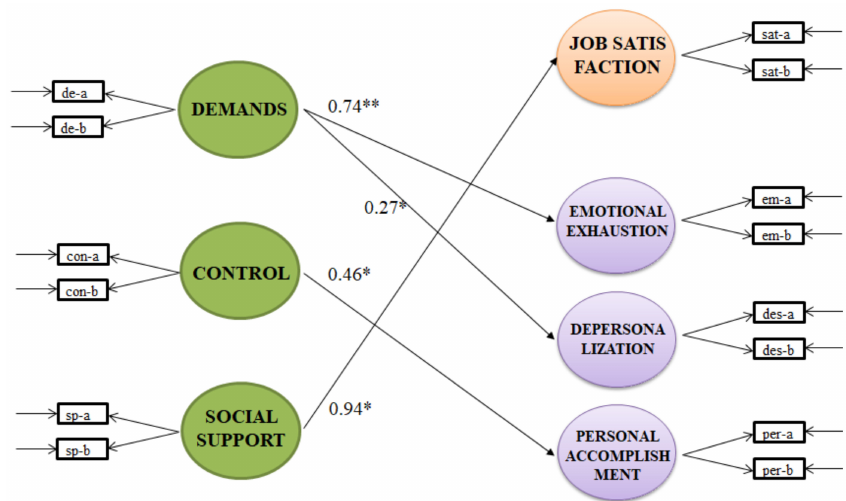
Figure 3. Standardized parameters of the model. Non-significant paths are omitted for presentation clarity. * p < 0.05, ** p < 0.01. de-a and de-b are the parcels that composed the latent variable of